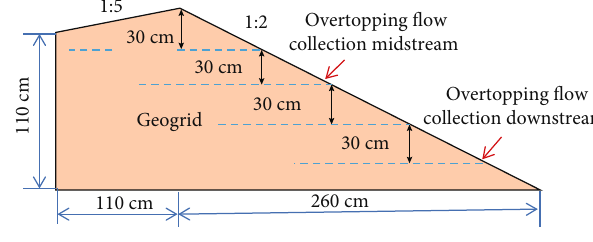
Figure 2: The schematic diagram of the geogrid.